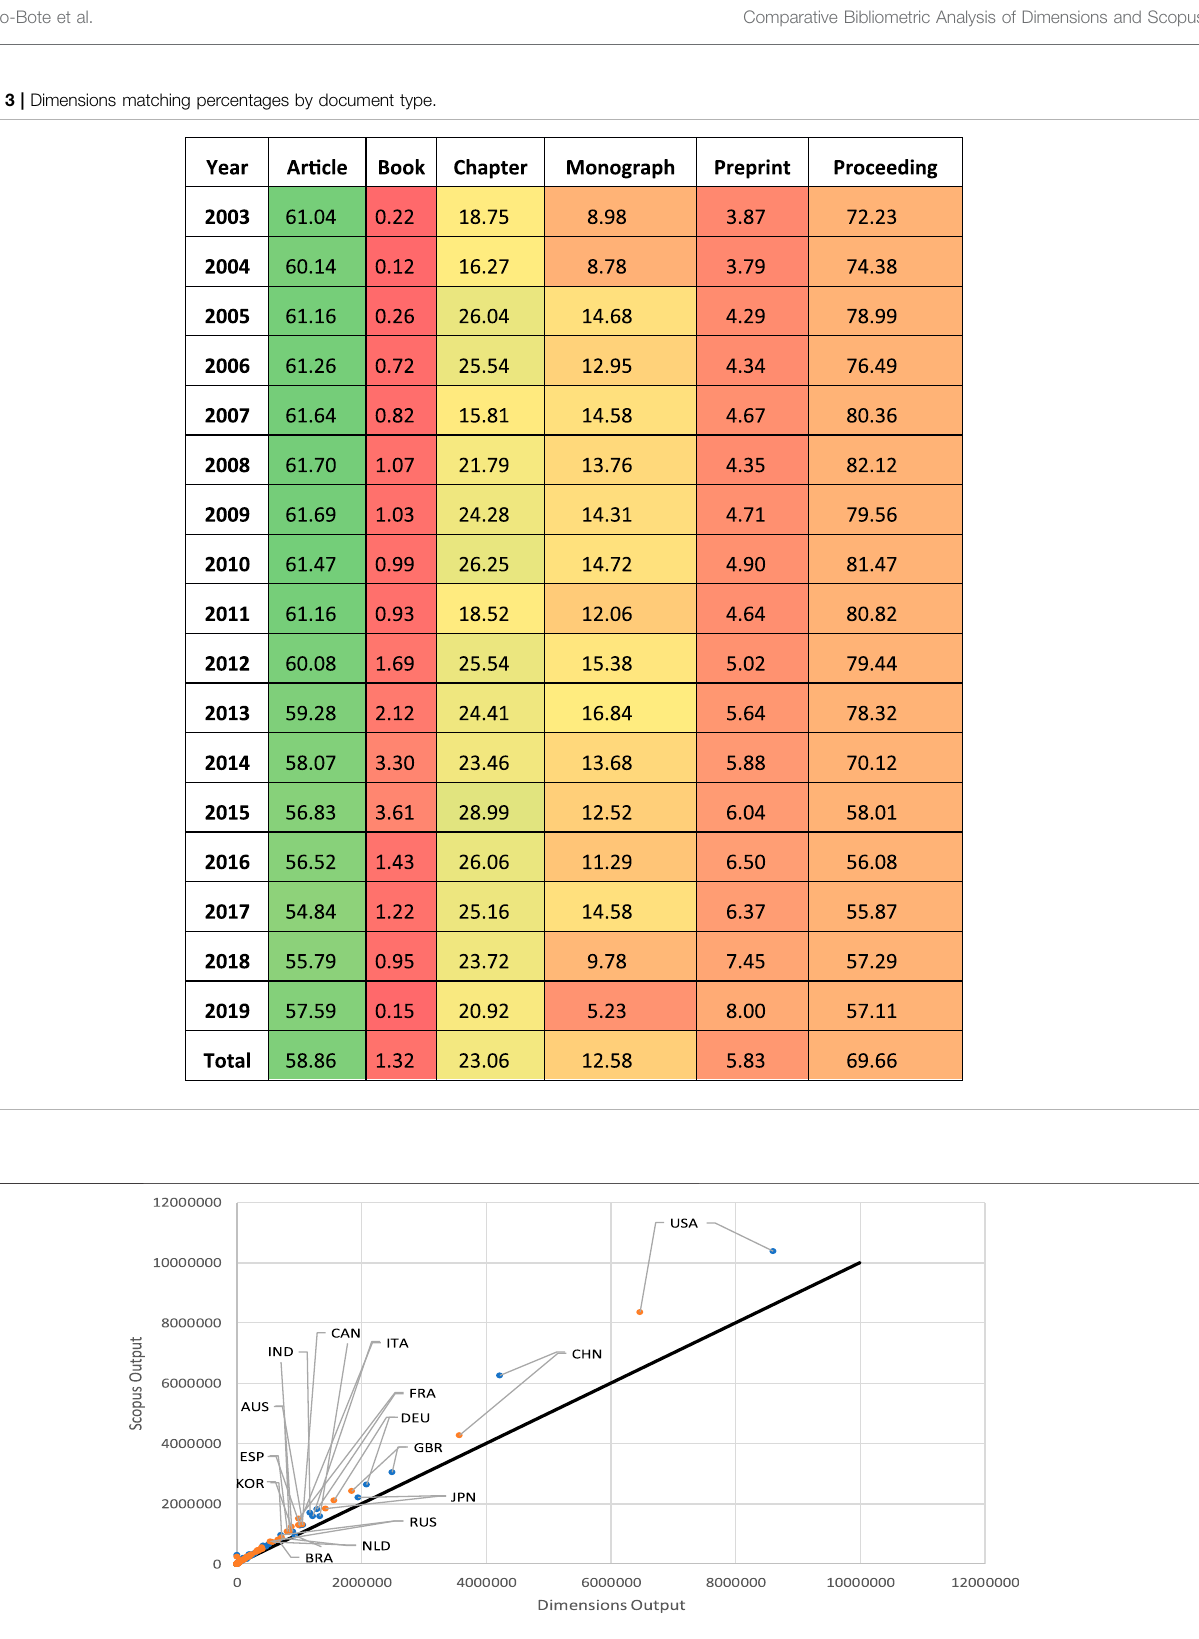
Frontiers in Research Metrics and Analytics |